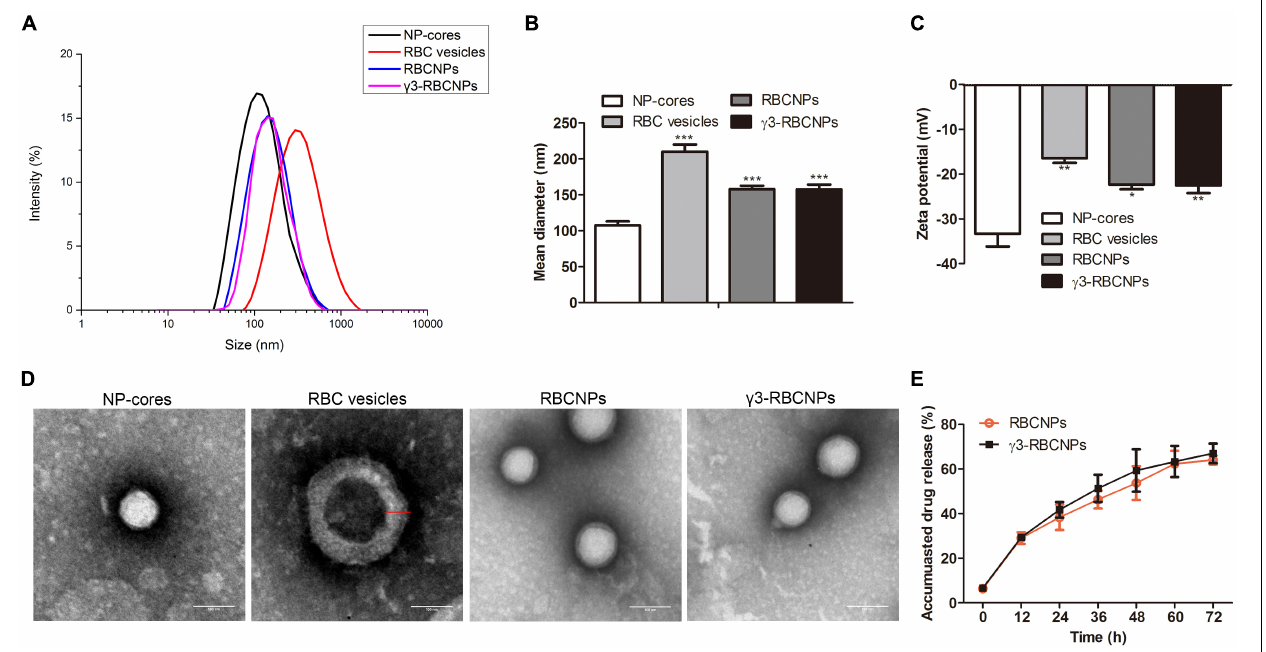
FIGURE 1 | Characterization of γ 3-RBCNPs. (A,B) DLS analysis of the size intensity (A) and mean diameter (B) of the prepared NPs. (C) Zeta potential of the prepared NPs. (D) TEM images of the NPs. Scale bar = 100 nm. (E) In vitro drug release curves of RBCNPs and γ 3-RBCNPs. * P < 0.05, ** P < 0.01, *** P < 0.001 vs. NP cores